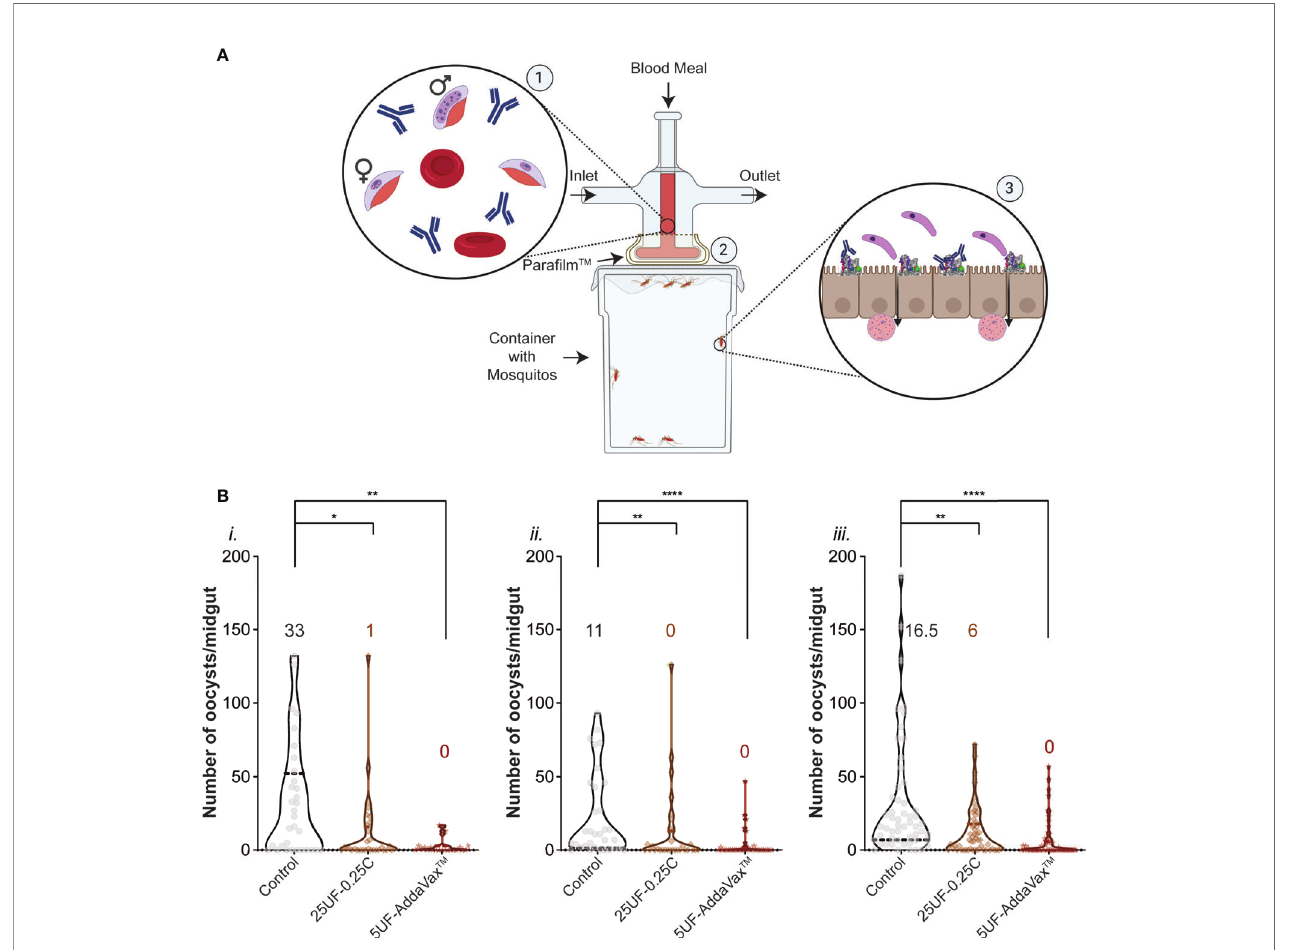
FIGURE 3 | Plasmodium falciparum transmission-reducing activity of immune sera elicited by the UF6b nanovaccine. (A) Schematic of the Standard Membrane Feeding Assay (SMFA). ① Puri fi ed total IgG is added to a gametocytemic blood meal ② which is then fed through a membrane feeder to Anopheles mosquitoes. ③ Within the mosquito midgut, antibodies bind to AnAPN1 and block transmission of the ookinete (top) through the epithelium. Ookinetes that can bind to AnAPN1 pass through and form oocysts (bottom) which are then counted. Figure created with BioRender.com. (B) Three independent replicates ( i. , ii. , iii. ) of the SMFA assay using a feed of 750 µg/mL of puri fi ed IgG per group. Control is untreated gametocytemic blood. Overlay numbers are median values of oocysts/midgut for each group. Mosquito sample sizes for each control/test group from left to right: ( i.) 32, 32, 23 ( ii. ) 33, 31, 34 and ( iii. ) 54, 53, 60. Dotted and bold lines correspond to the quartiles and median, respectively. Signi fi cance ( a = 0.05) was calculated by Kruskal-Wallis test with Dunn ’ s post hoc correction. *p < 0.05, **p < 0.01, ****p <